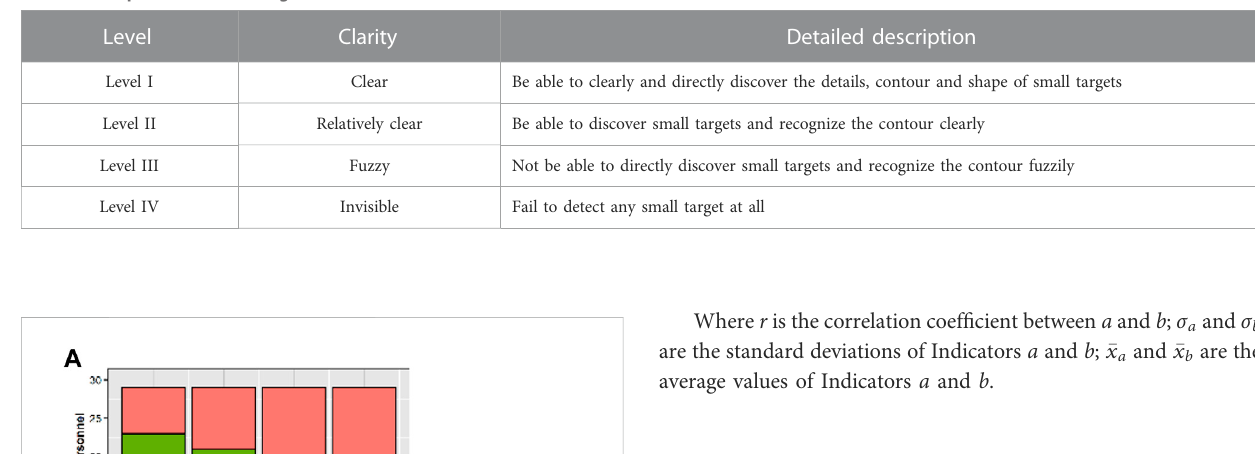
TABLE 2 Component of visual cognition.